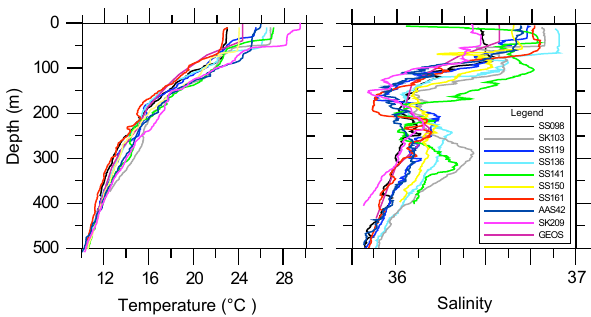
Fig. 8. Temperature and salinity records to 500m depth during the visits to the GEOSECS site (for dates, see Fig.